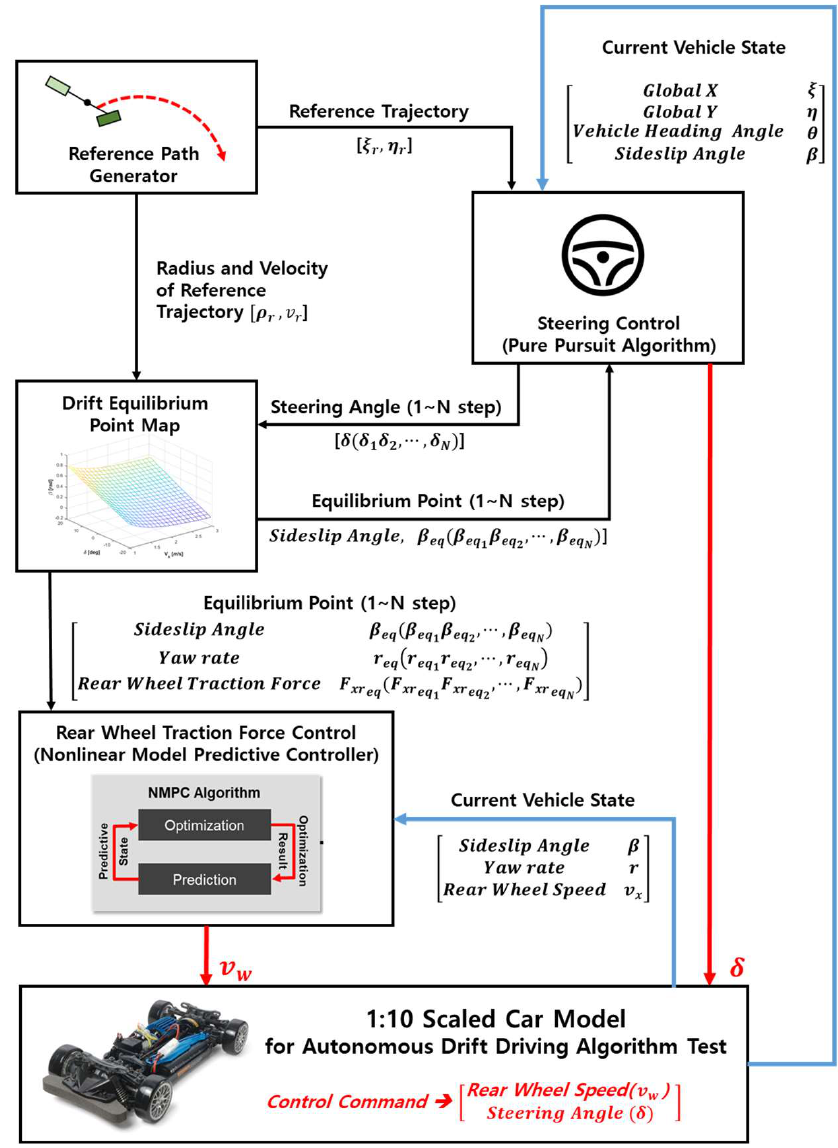
Figure 6. The 1:10-scale nonlinear model predictive control-based drift control system.